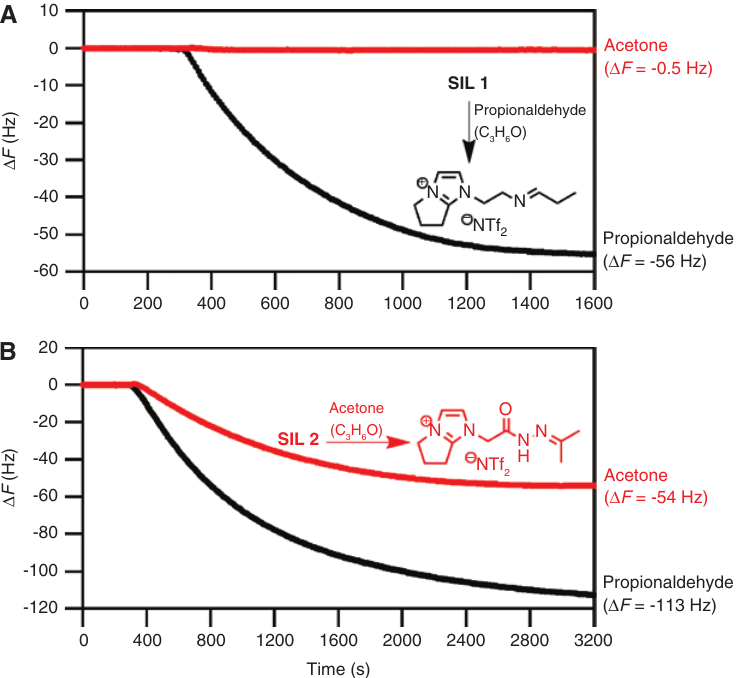
H O) by 9 MHz 3 6